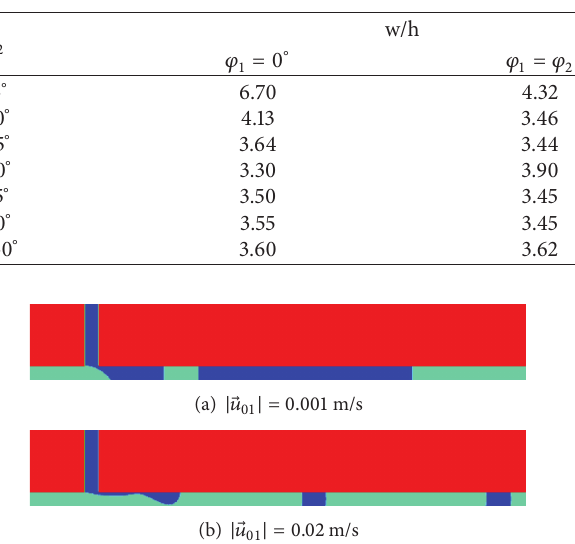
Figure 5: Simulated segment flow mode in a T-shaped microchan- nel at | ⃗𝑢 02 | = 0.005 m/s, and (a) | ⃗𝑢 01 | = 0.001 m/s; (b) | ⃗𝑢 01 | = 0.02